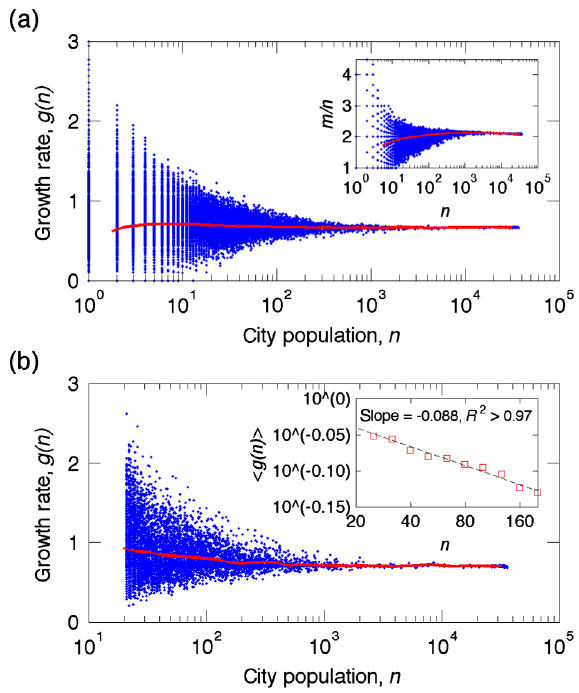
FIG. 3 (color online). Growth factor by population size, for M ¼ 225 (a) and M ¼ 50 (b). The inset in (a) shows the =n scatter plot of m , by population size. Note the resemblance i i to the distribution of g ð n Þ . The average growth factor h g ð n Þi is shown as a solid line in both panels. Note the subtle shift as the box size increases: For the larger boxes in (b), there appears an initial weak power-law decay, consistent with an exponent x in the 95% confidence interval: [0.078,0.098] (inset).